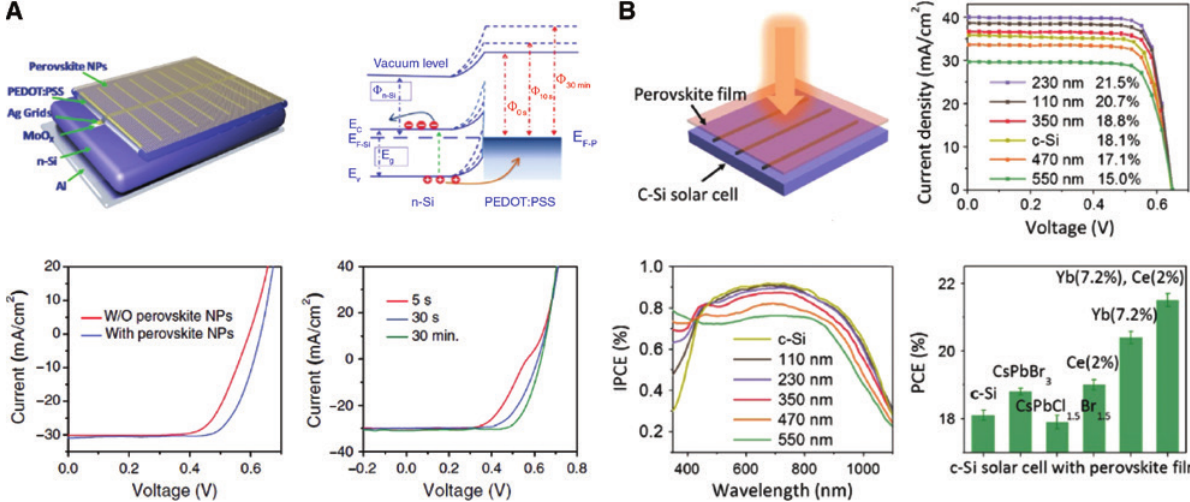
Figure 5: (A) “Field-effect solar cell” by using spherical hybrid organic-inorganic metal halide nanocrystals. Reproduced with permission from [214]. Copyright 2017, Wiley-VCH. (B) CsPbCl Br :Yb (7.1 %), Ce (2 %) perovskite nanocubes film, used as a downconverter in 1.5 1.5 commercial silicon solar cells. Reproduced with permission from [19]. Copyright 2017,